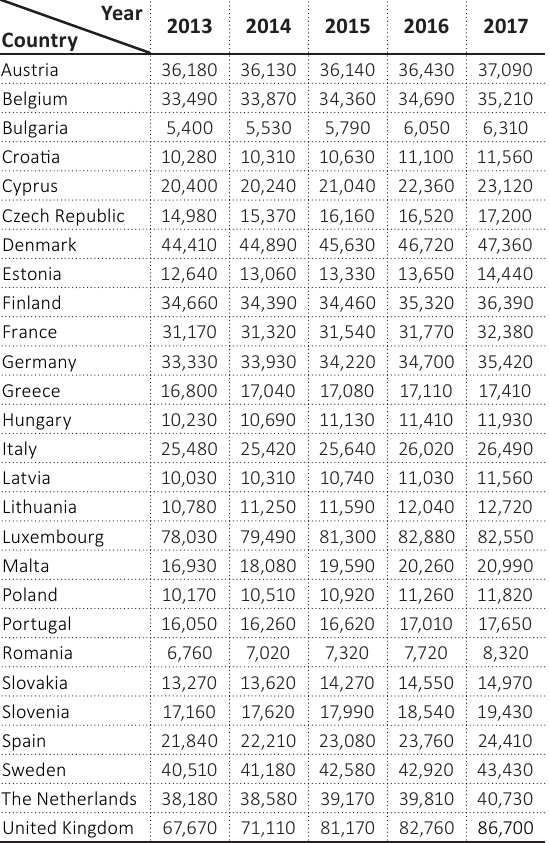
Table 7. Real GDP per capita in individual EU member states in euro